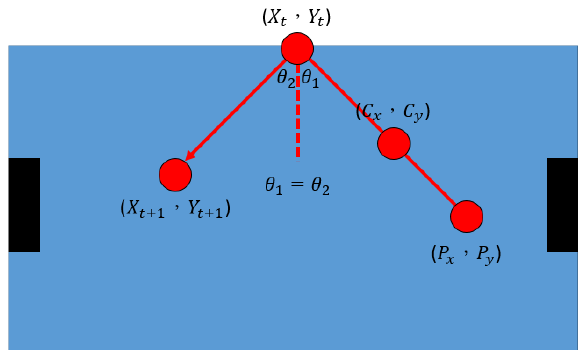
Figure 7. Schematic diagram of linear formula combined with the law of reflection.